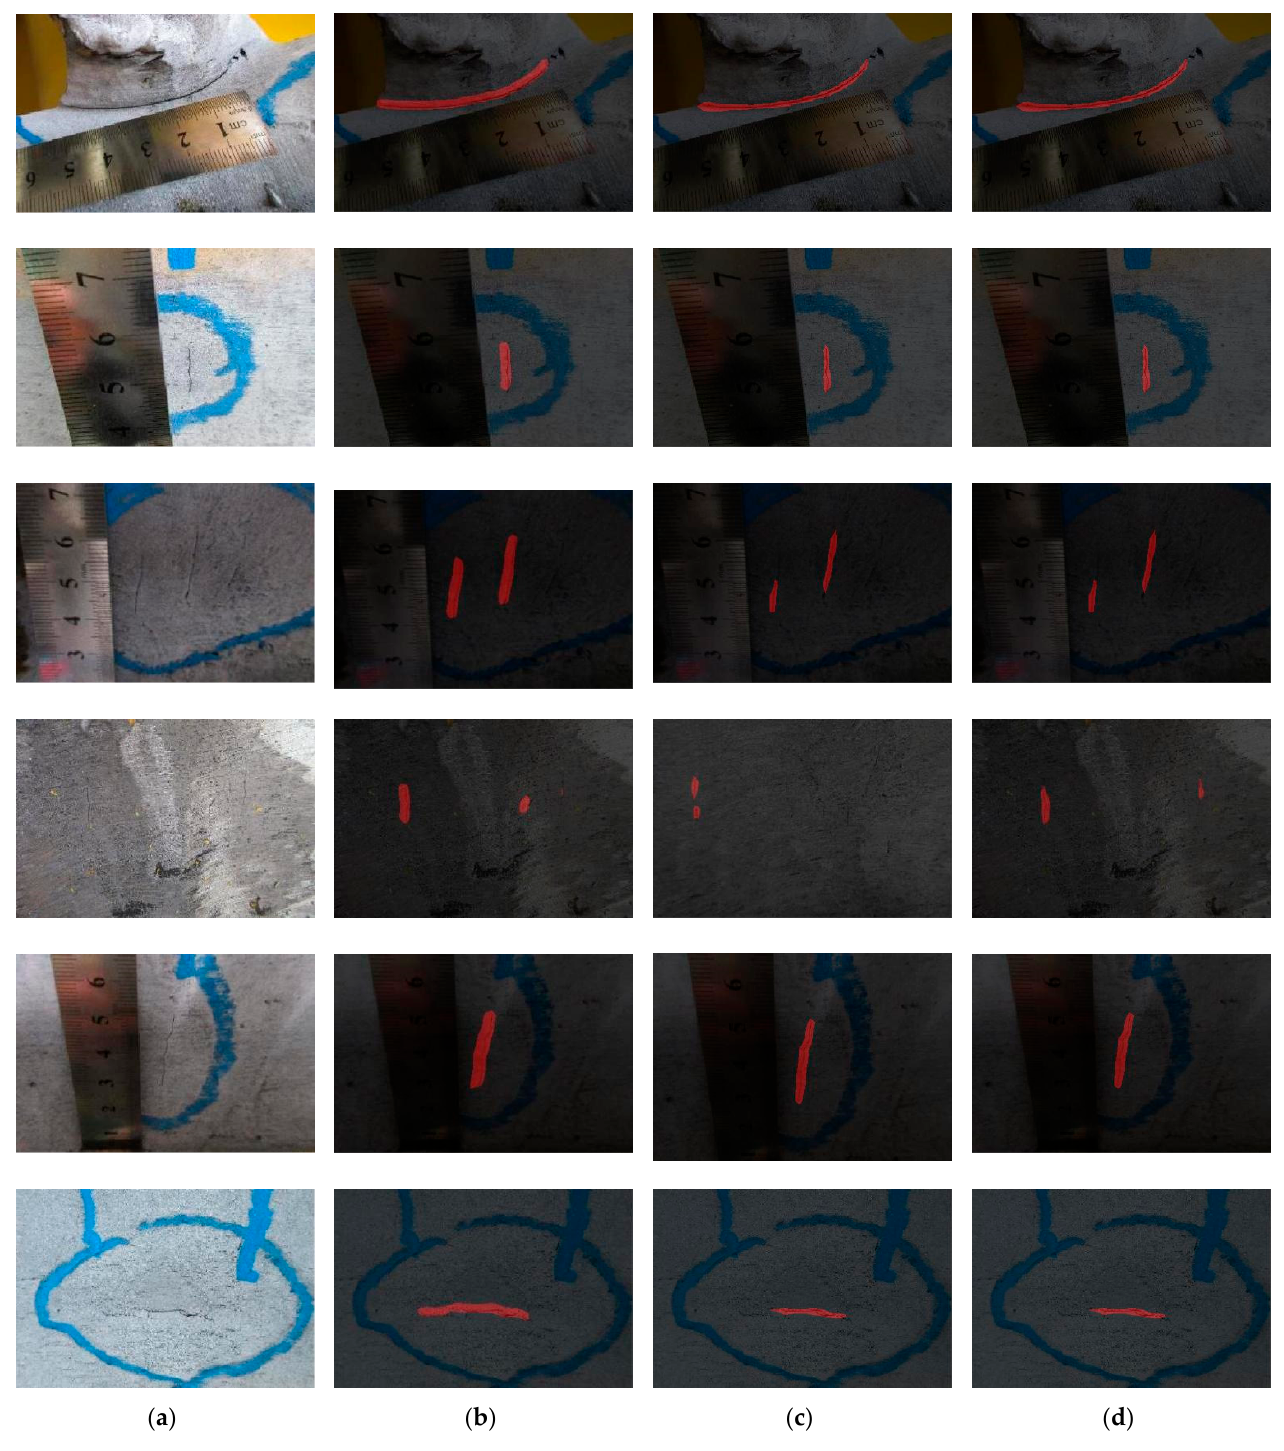
Figure 16. Results of crack identification by different semantic segmentation: ( a ) original image; ( b ) PSPNet; ( c ) MobileNetv2-PSPNet; ( d ) improved model.